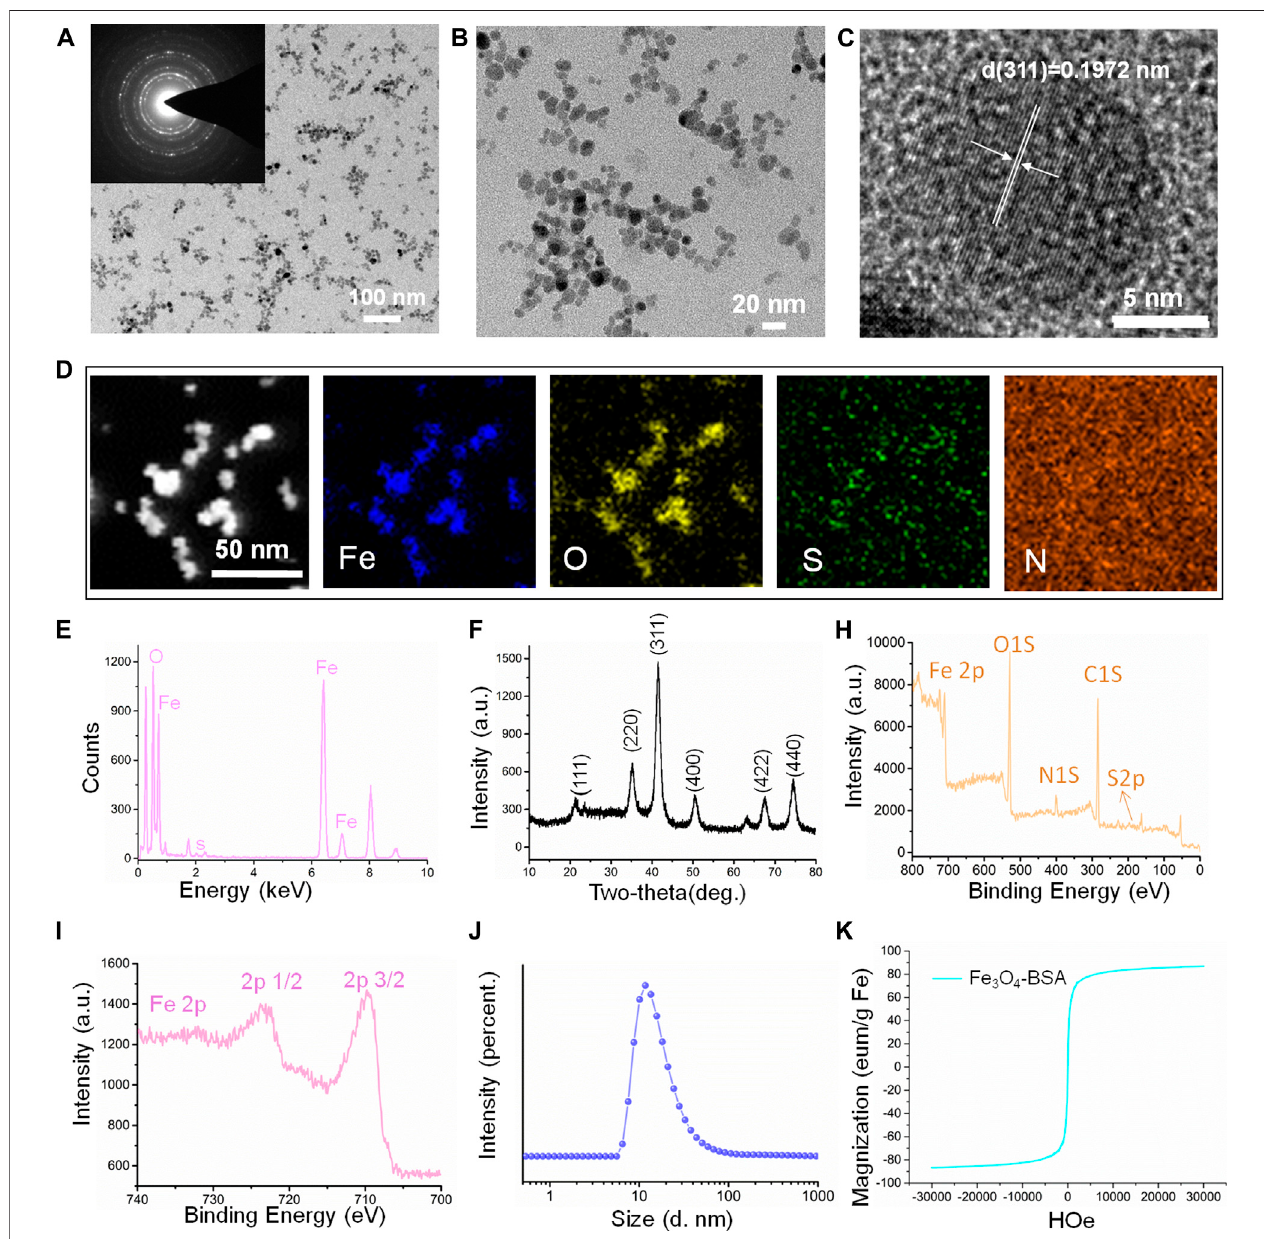
FIGURE 1 | Characterization of the magnetic nanoparticles (Fe 3 O 4 -BSA NPs). (A, B) TEM and magni fi ed TEM images of Fe 3 O 4 -BSA NPs (the inset image is the corresponding SAED pattern). (C) HRTEM image. (D, E) HAADF-STEM elemental mapping images and EDX patterns of Fe 3 O 4 -BSA NPs. (F) X-ray diffraction pattern. (H,I) XPSspectrumofFe 3 O 4 -BSANPsandspectraofFe2porbitsforthebindingenergycurve. (J) SizedistributionofFe 3 O 4 -BSANPsinultrapureaqueoussolution. (K) The MH hysteresis curve of Fe 3 O 4 -BSA NPs.